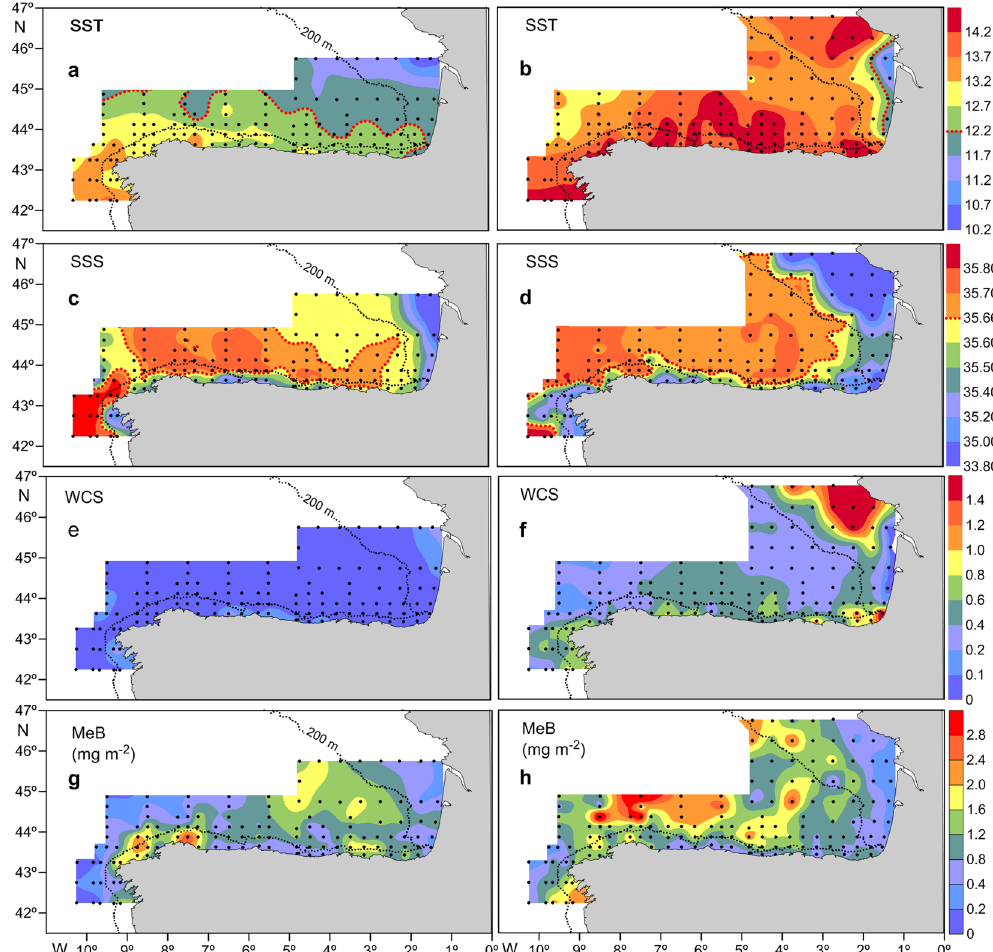
Figure 2. Horizontal distribution of: ( a ) Sea surface temperature (SST, °C at 5 m depth) during the CAREVA cruise (CC). ( b ) SST during the JUREVA cruise (JC). ( c ) Sea surface salinity (SSS, salinity at 5 m depth) during the CC. ( d ) SSS during the JC. ( e ) Water column stratification (WCS, differences in water density between 200 m or 5 m above the bottom and 5 m depth) during the CC. ( f ) WCS during the JC. ( g ) Mesozooplankton biomass (MeB, mg m − 2 ) during the CC. ( h ) MeB during the JC. The dotted redlines in a and b indicate the 12.2 °C isotherm and in c, and d the 35.66 isohaline.